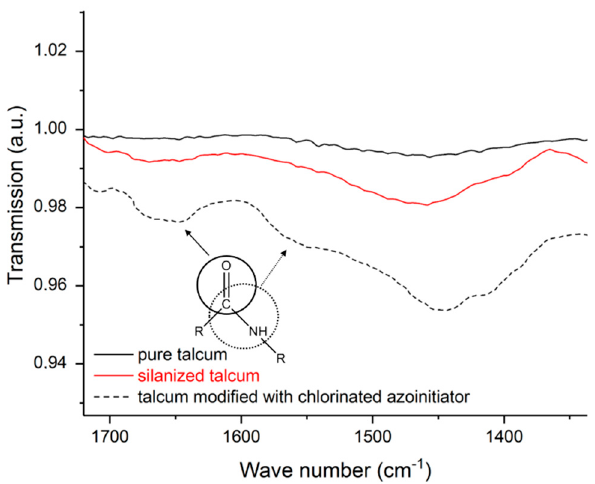
Figure 3. Selected ranges of infrared spectroscopy of pure, salinized, and talcum modified with chlorinated azoinitiator.